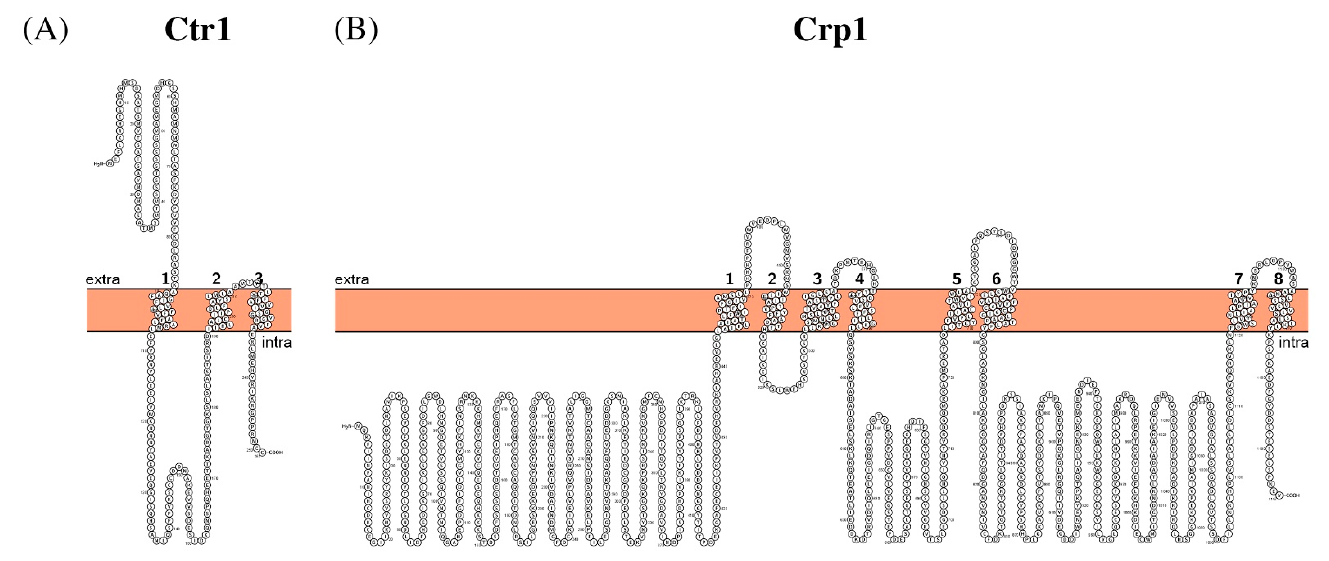
Figure 8. Schematic representation of the proposed secondary structure and topology of Ctr1 ( A ) and Crp1 ( B